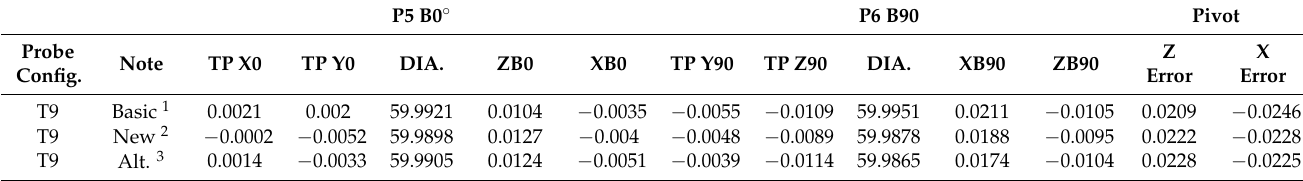
Table 13. Comparison of probing data results with three sets of the T9 probe. Results in [mm]. P5 B0 ◦ P6 B90